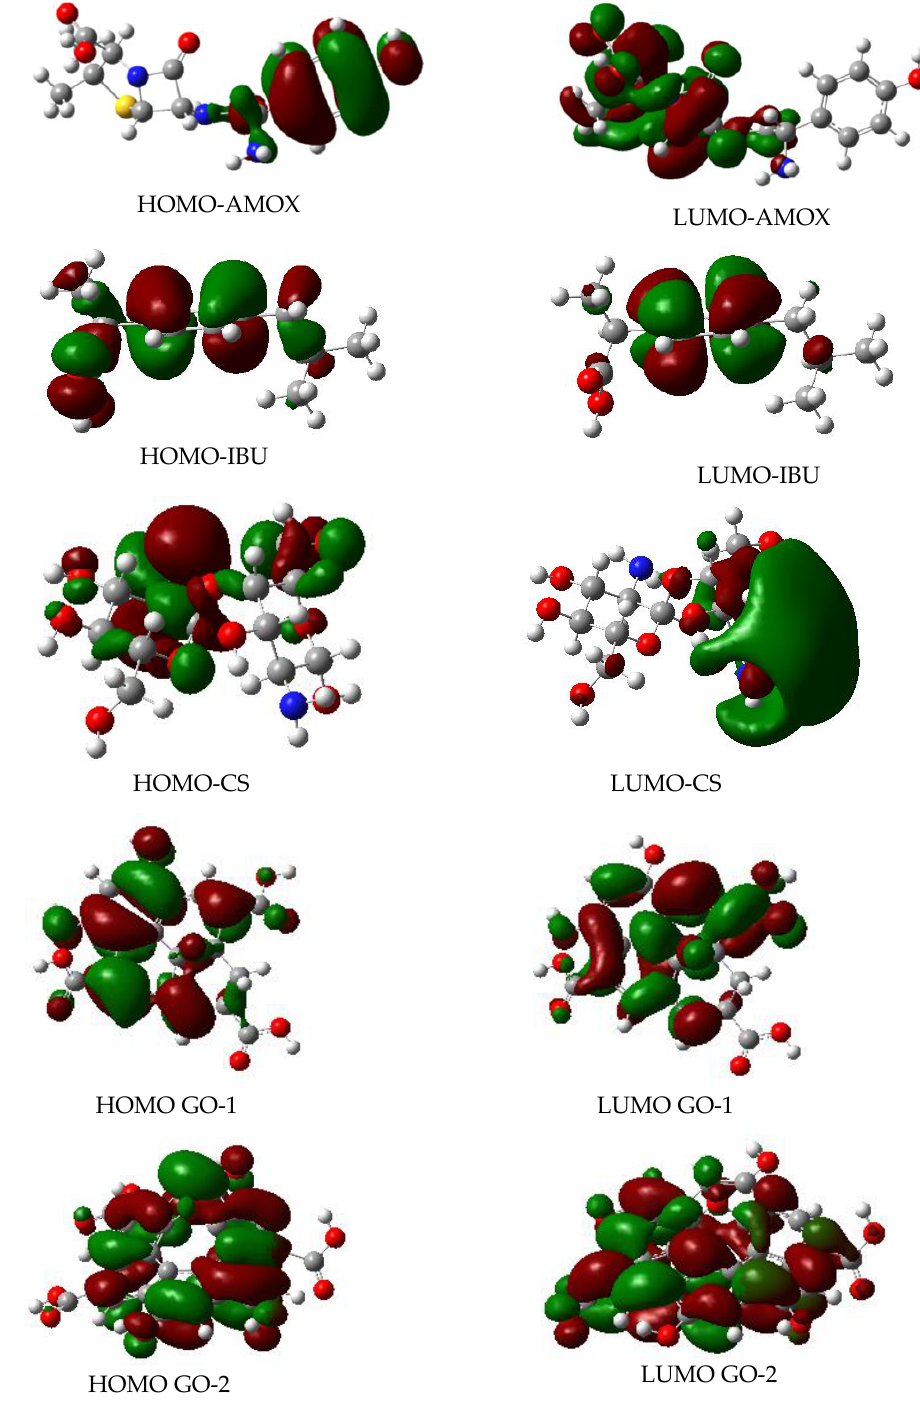
Figure 2. Frontier molecular orbitals for compounds studied in this work. HOMO: Highest occupied molecular orbital; LUMO: lowest unoccupied molecular Orbital obtained at wB97X-D/6311G(2d,p) theory level. AMOX = amoxicillin; IBU = ibuprofen; CS = chitosan; GO-1 = pyrene-based graphene; GO-2 = coronene-based graphene.